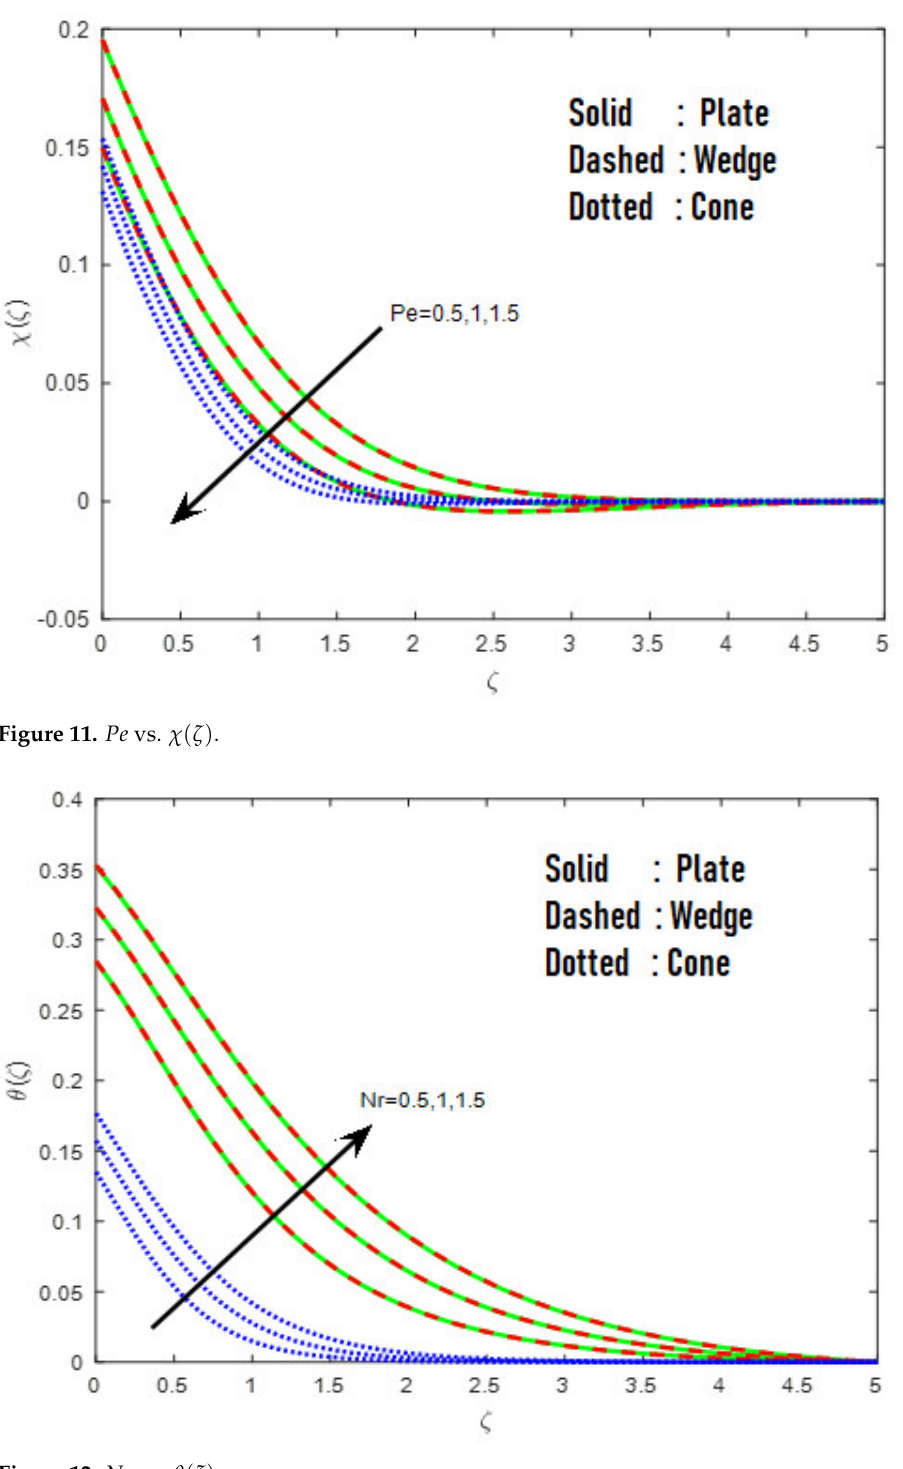
Figure 12. Nr vs. θ ( ζ ) Figure 12. Nr vs.     . Figure 12. Nr vs.     .